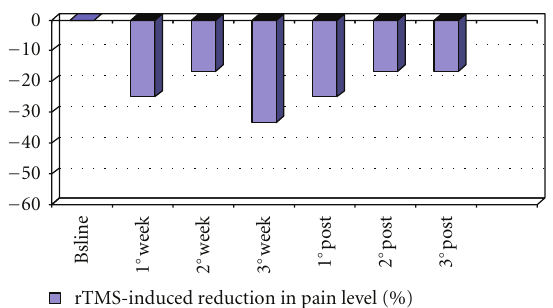
Figure 1: The graph shows the reduction in percentage of pain in time. The percentage of pain level modification was calculated from the VAS score by the following equation (post.rTMS − pre.rTMS pain scores) × 100/(pre.rTMS pain